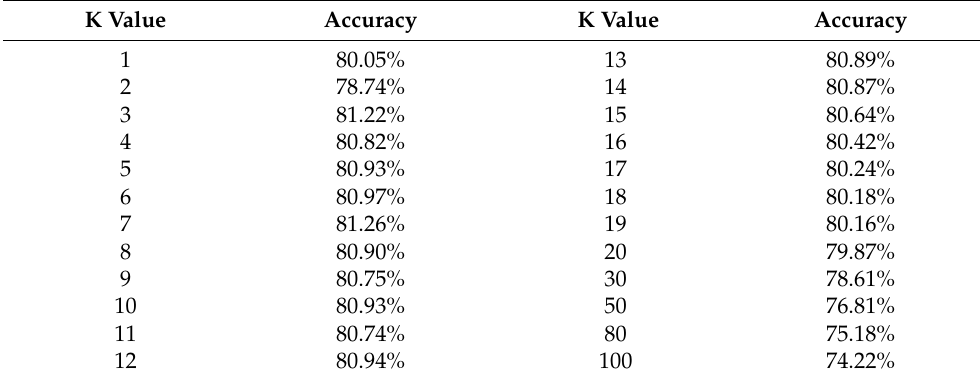
Table 4. Classifier accuracy corresponding to different K